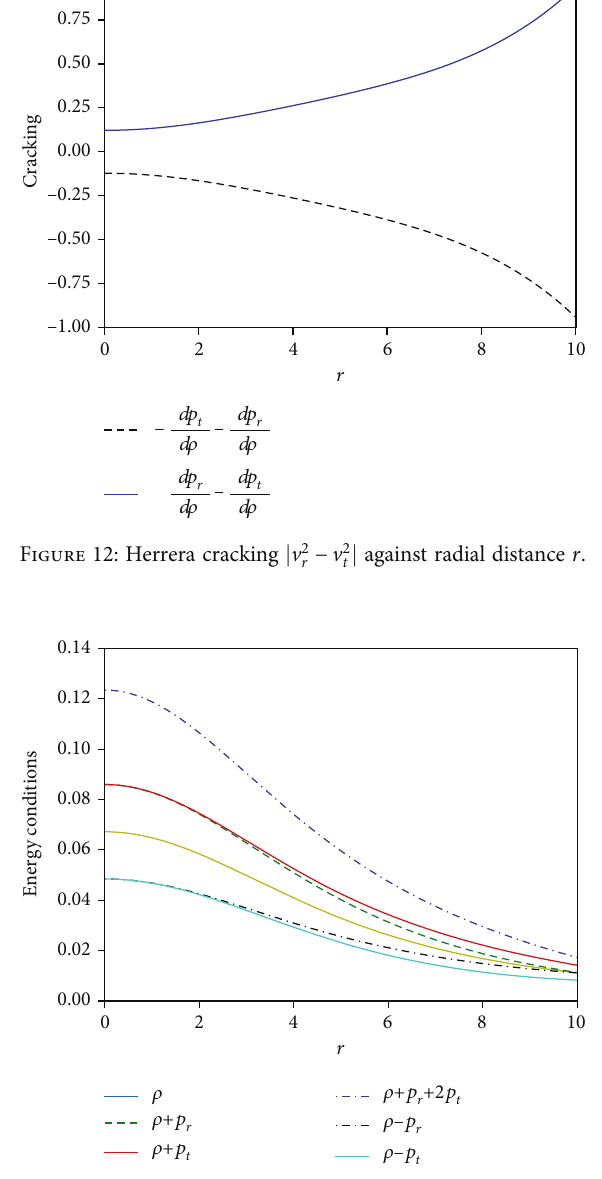
Figure 13: Energy conditions against radial distance r